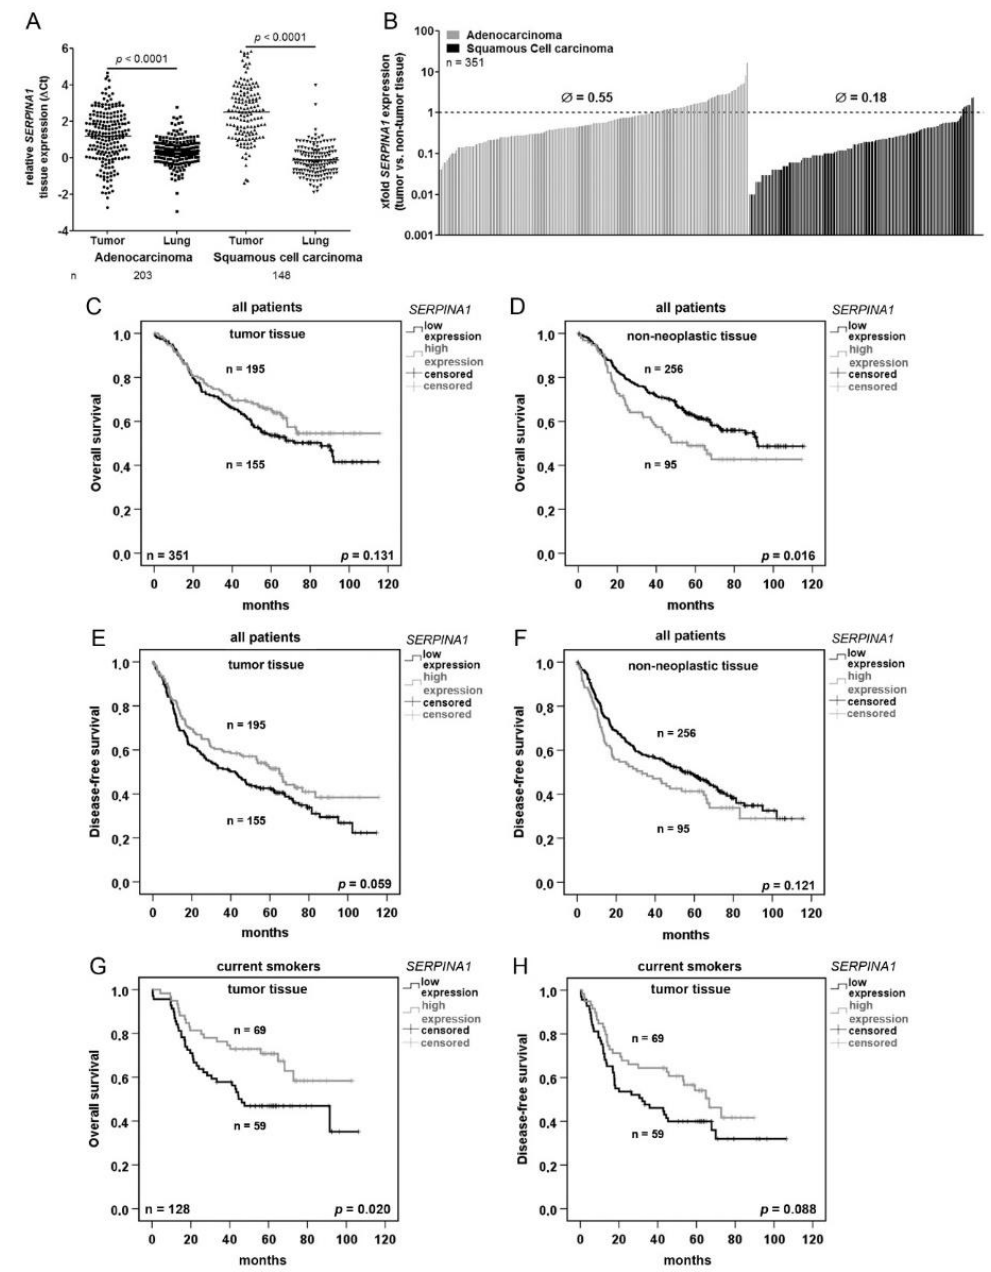
Figure 1. SERPINA1 expression is downregulated in NSCLC and is a prognostic factor for overall and disease-free survival. ( A ) Relative expression ( ∆ Ct) of SERPINA1 in tumor and in paired non-tumor lung tissues. SERPINA1 expression was normalized to reference genes ESD and RPS18 . A higher relative value means a lower gene expression. ( B ) SERPINA1 expression ratio (tumor vs. non-tumor lung tissue) in 351 NSCLC patients. Dotted line indicates equal expression in tumor and lung tissue. ( C – F ). Kaplan-Meier overall and disease-free survival curves for all patients. ( G ) and ( H ) Kaplan-Meier overall and disease-free survival curves for current smokers. The program cut-off finder (http://molpath.charite.de/cutoff/) was used to define the values separating the groups. p < 0.05 was considered significant.